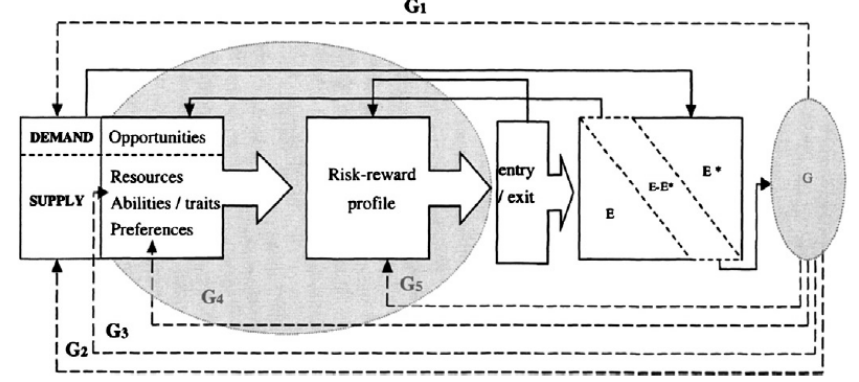
Fig. 1. Framework of determinants of entrepreneurship (adopted from Verheul et al.,